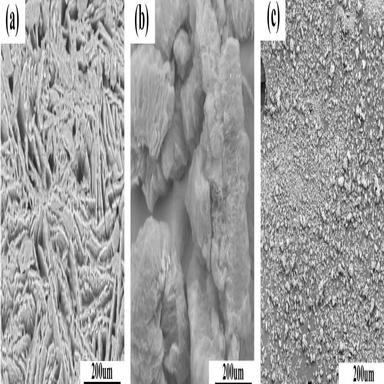
SEM images of (a) PA, (b) EG and (c) Si3N4.